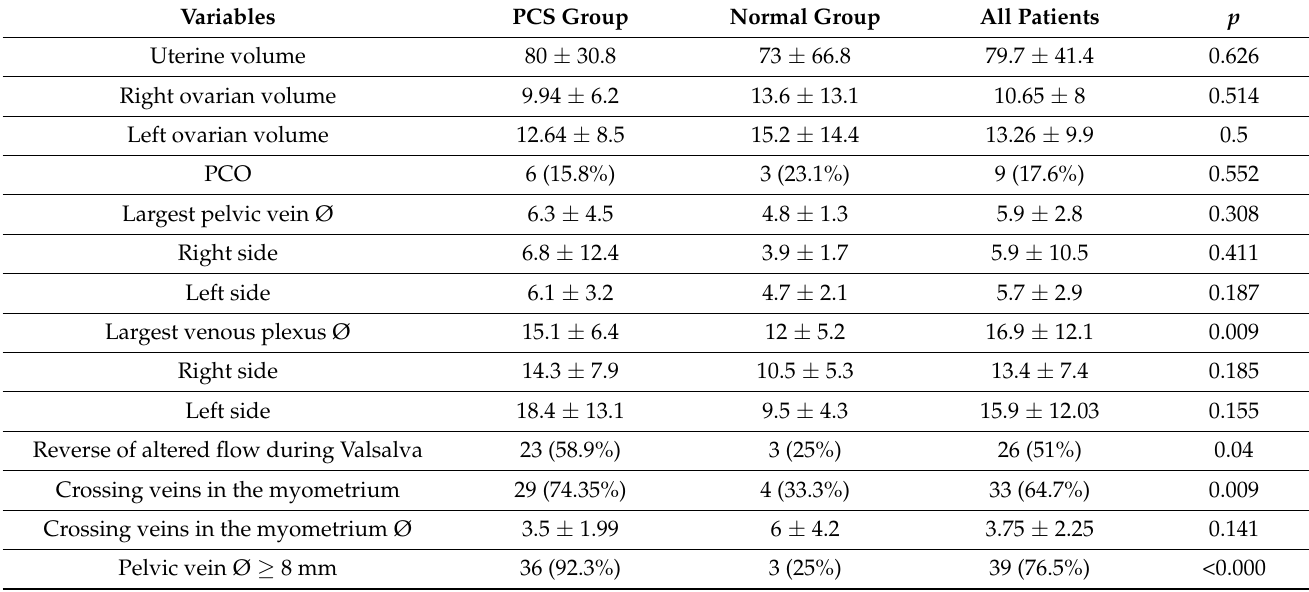
Table 2. Ultrasound Parameters.